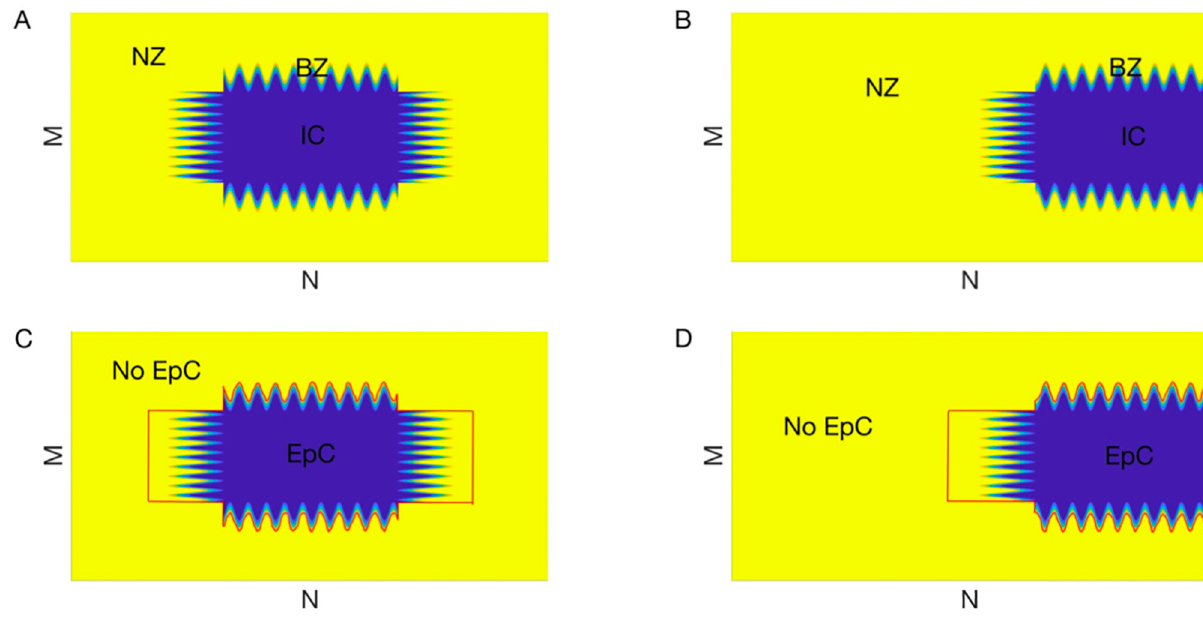
Fig 1. Two different locations of ischemic core (IC, blue) with complex geometry of border zone (BZ). (A) in the middle; and (B) on the right hand side of the lattice. Normal zone (NZ) is shown in yellow. Heterogeneous EpC is applied in the regions enclosed by red curves in (C) and (D).